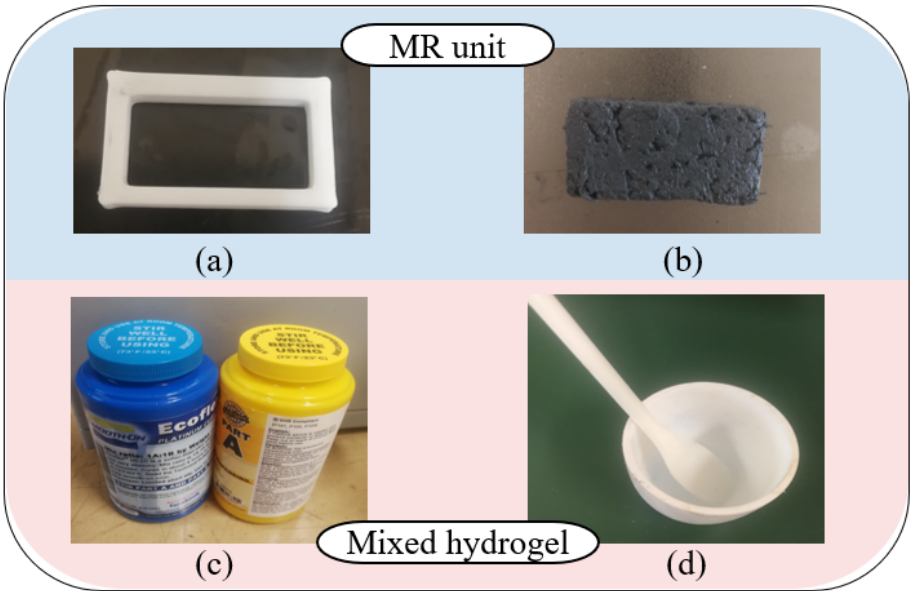
Figure 5. The related components for preparation: ( a ) 3D-printed mold used for MR unit; ( b ) actual display of MR unit; ( c ) mixture A and mixture B for hydrogel rubber; ( d ) porcelain container for mixing.